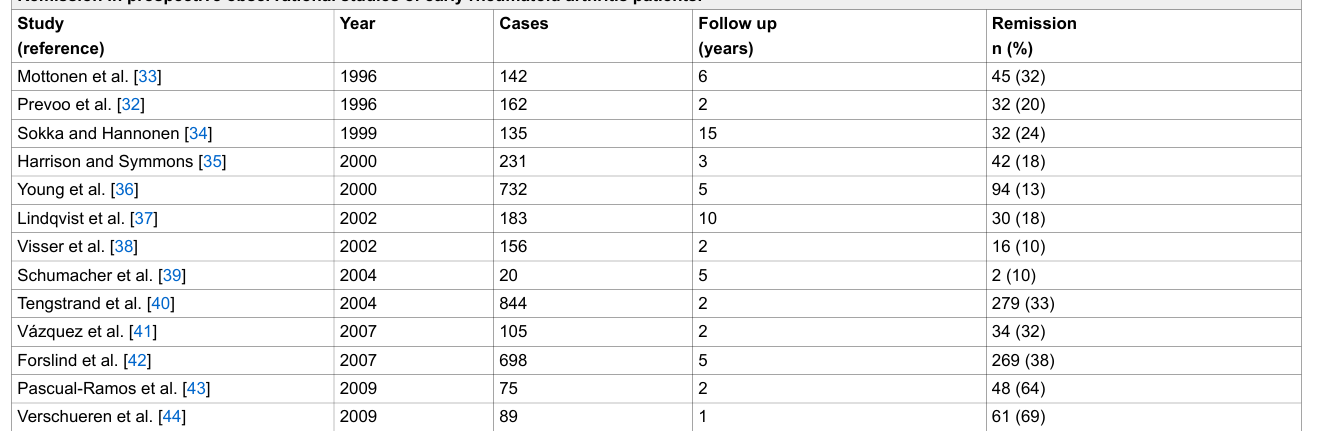
Table 3 Remission in prospective observational studies of early rheumatoid arthritis patients. Study